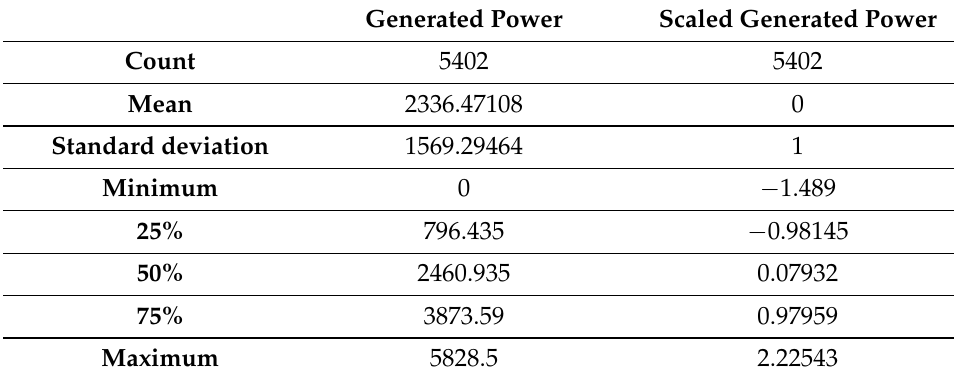
Figure 5. Block Diagram of the System. Table 6. Statistical Summary for The Generated Power